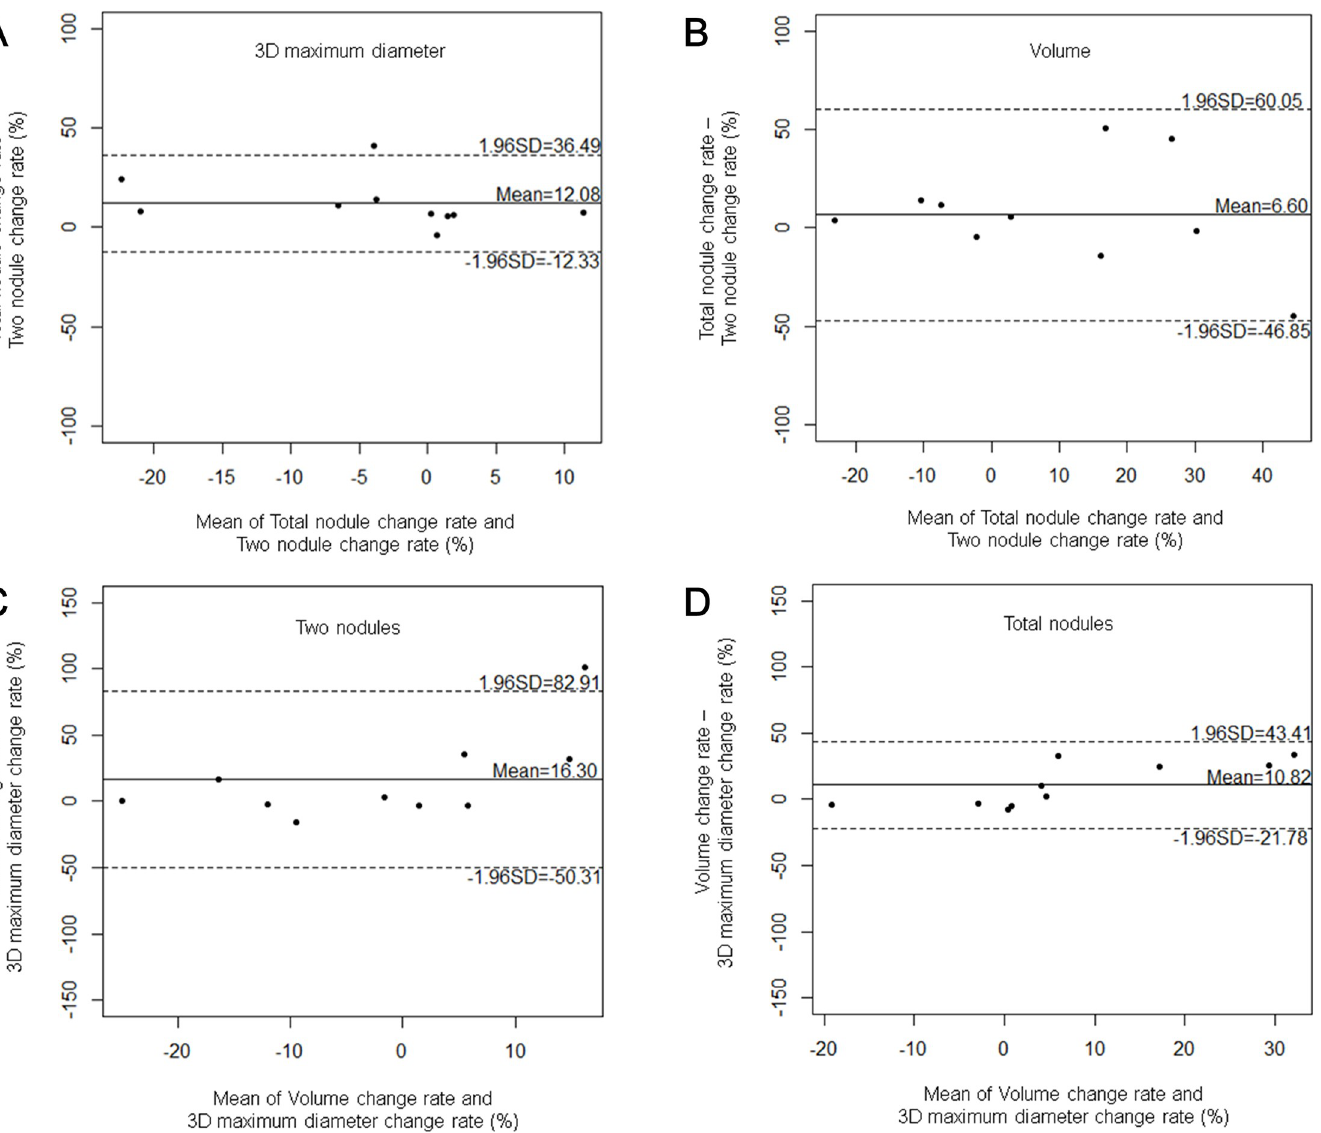
Fig 3. Bland-Altman plots of change rates between two time points according to the number of selected nodules and the measurement method. Plots show differences of change rates between two and total nodules estimated by 3D maximum diameter (a) and volume (b) measurements. Plots show differences of change rates between 3D maximum diameter and volume measurements in the selection of two (c) and total (d) nodules.